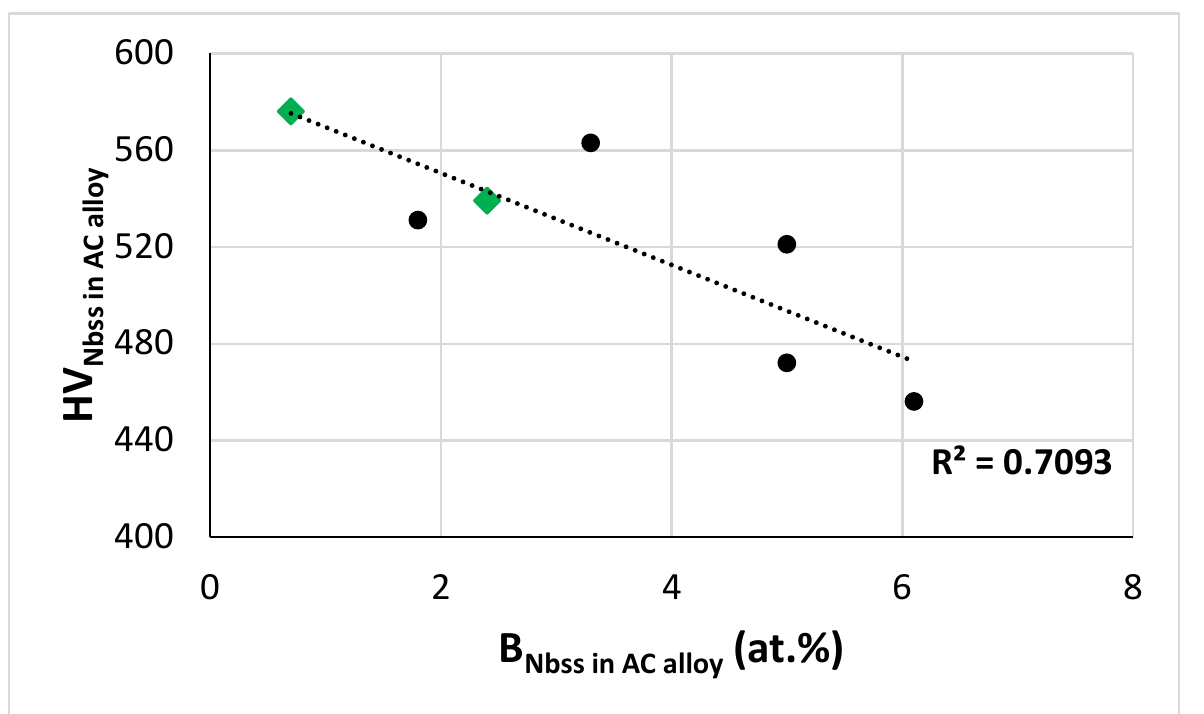
Figure 15. Hardness of the Nb ss in AC boron containing KZ series alloys versus the B concentration of the solid solution. Data for the alloys TT1, TT2, TT3, TT4, TT5, TT7 and TT8. Green diamonds for Nb ss in RM(Nb)ICs/RCCAs. All data R 2 = 0.7093.